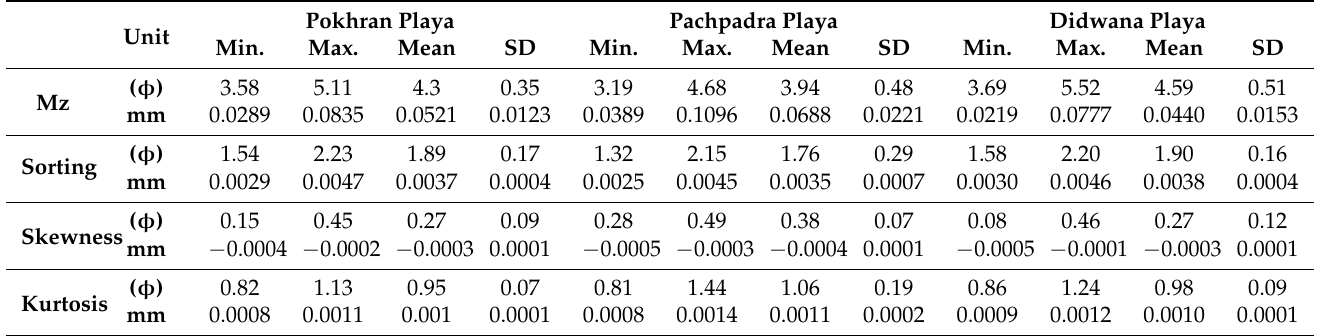
Table 2. Descriptive statistics for the grain size parameters of Pokhran, Pachpadra, and Didwana playas ( n =